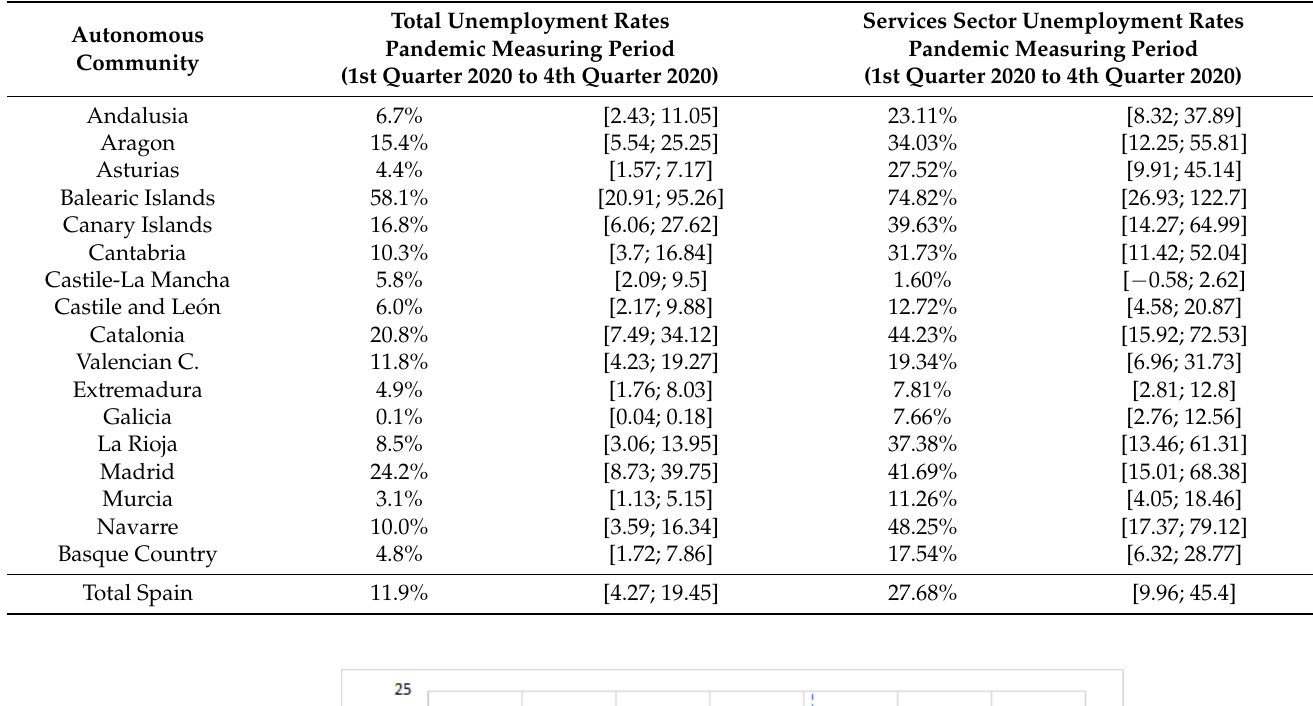
Table 3. Bayesian structural time series model results for the employment market: relative cumulative effect and 95% Bayesian credible interval.